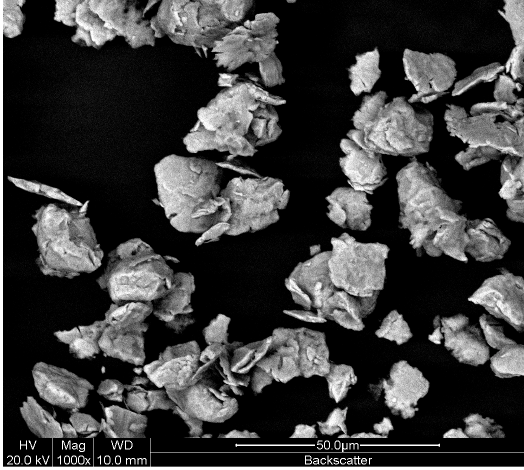
Figure 3. BSE image of unprocessed Cr powder.